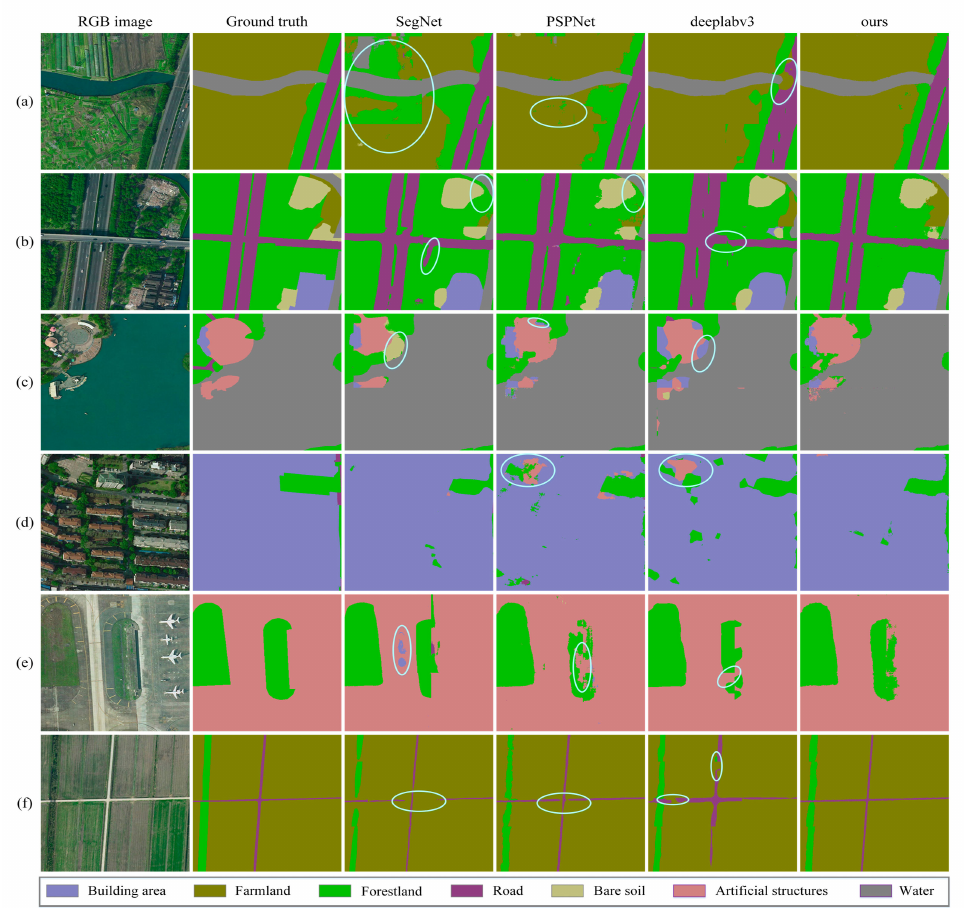
Figure 9. Examples of land cover classification results for the Shanghai dataset. The circles in white represent incorrect classification. ( a – f ) are six subsets land cover classification results from Shanghai